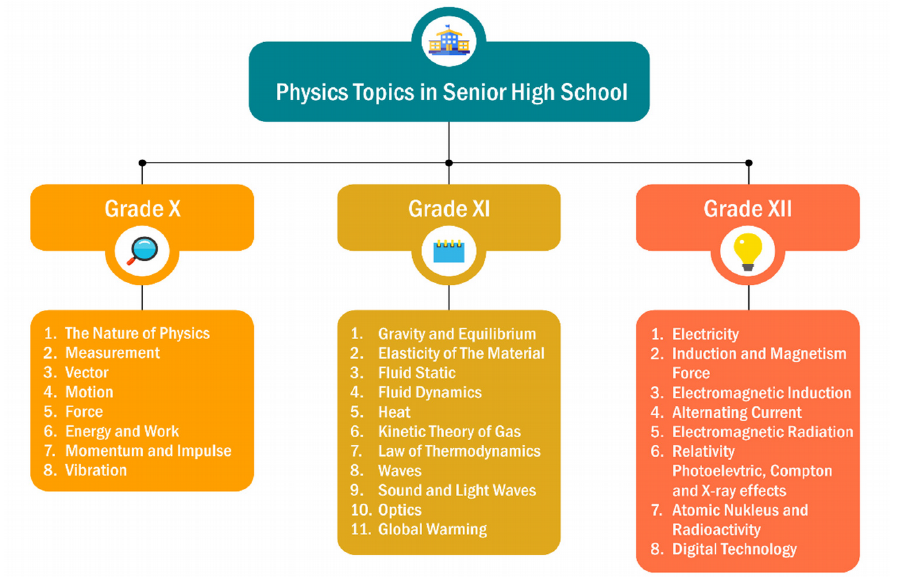
Figure 2. Physics topics in senior high